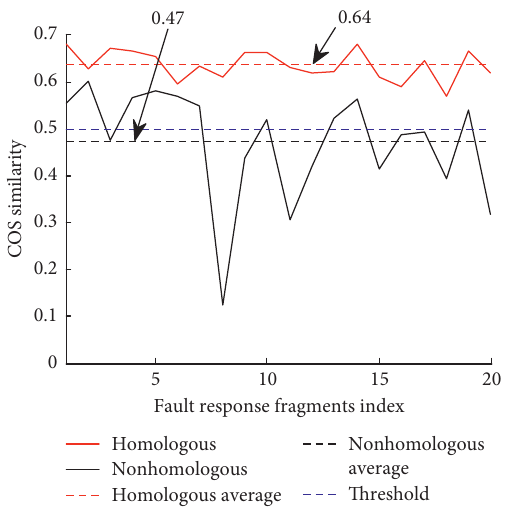
Figure 6: The simulation similarity result by FMPP. Table 2: Settings of simulation parameters. Parameter